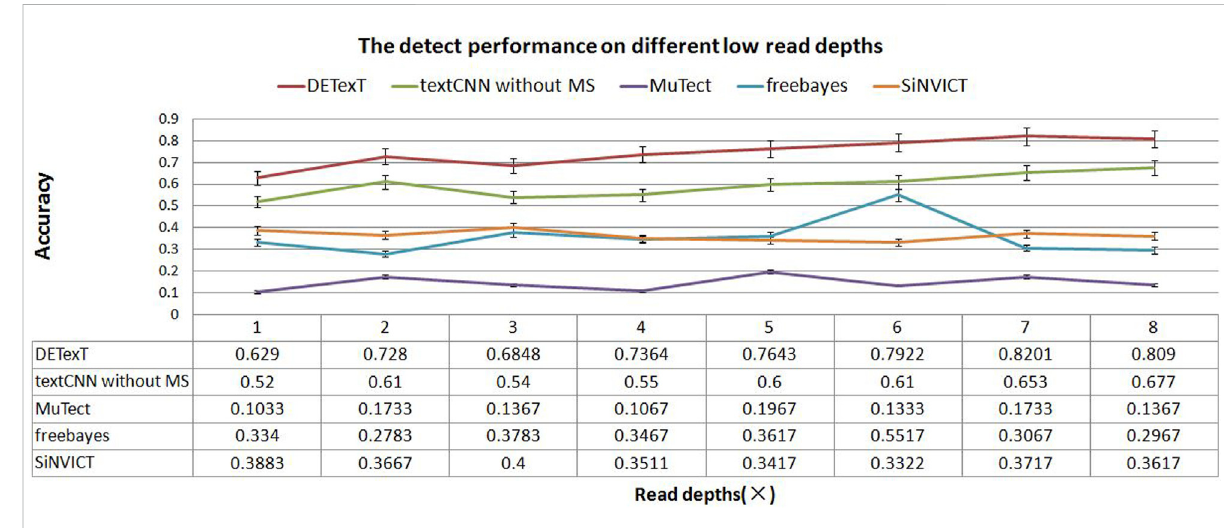
FIGURE 6 Detection performance at different low read depths. The experimental results of DETexT were compared with those of textCNN without MS, MuTect, freebayes, and SiNVICT on datasets with read depths of 1 –